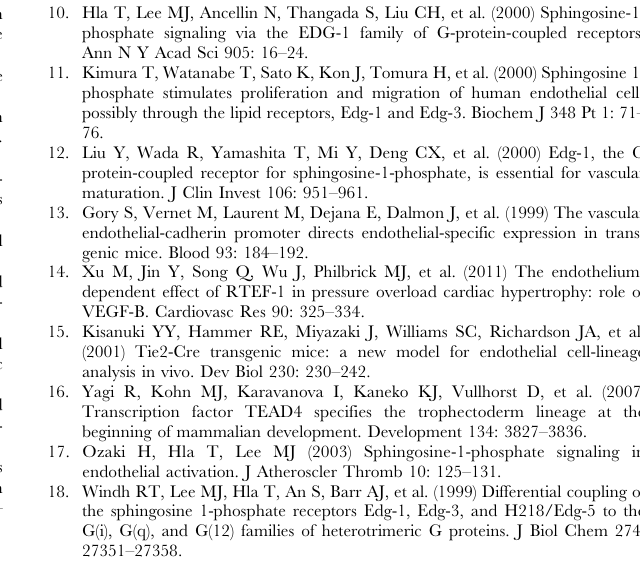
Figure S1 DNA microarray of RTEF-1 gene knockdown by RTEF-1 siRNA in HUVEC. Compared to negative control siRNA, knockdown of endogenous RTEF-1 by three different duplexes of RTEF-1 siRNA in HUVEC decreased Edg-1 gene expression. Data was analyzed by Ingenuity Pathway Analysis software (Ingenuity System, Redwood City, CA). Figure S2 Cx43 (A) and Edg-1 (B) mRNA in RTEF-1 o/e and control HMEC-1s in 6 h and 24 h Matrigel. Total RNA was extracted from cell lysates obtained from dissolved cell networks in 6 h and 24 h Matrigel. Quantitative real-time PCR amplification was performed. The results were quantified based on three experiments and are presented as mean 6 S.D. (*= p ,